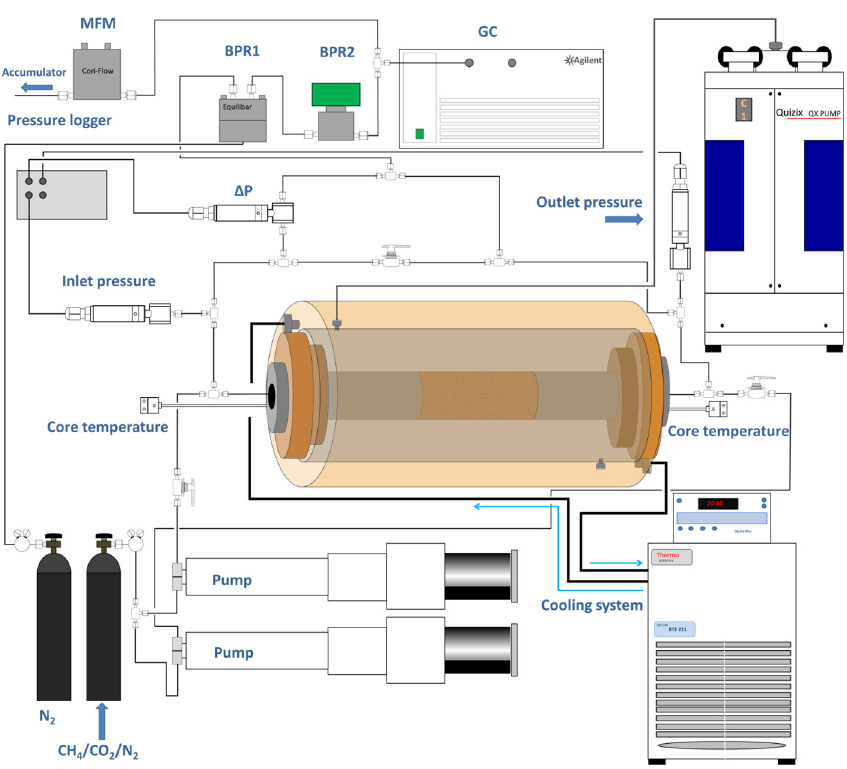
Figure 3. Illustration of the second experimental setup, where an in line GC and mass flow meter assisted in determining the effluent gas composition.